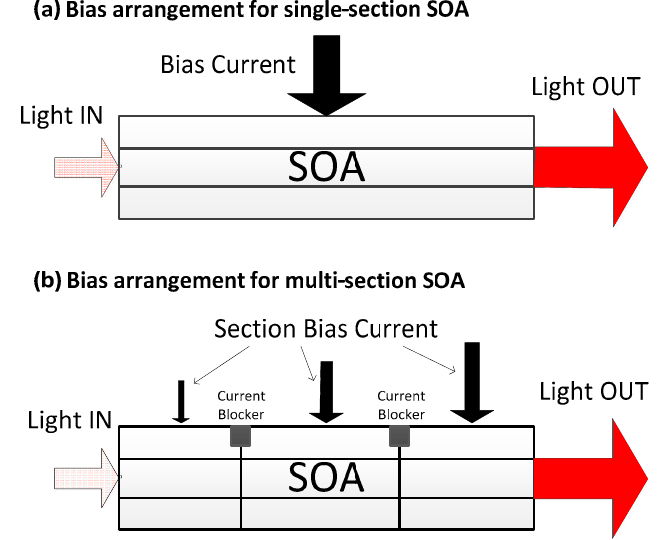
Figure 2. ( a ) Simplified schematic of a travelling wave single-section SOA where the population inversion is created by biasing the whole amplifier with a single current; ( b ) Multi-section SOA, the bias currents to the smaller amplifier sections are independently set. The multi-section biasing arrangement creates an SOA with improved noise and gain saturation performances compared to the case in ( a ).